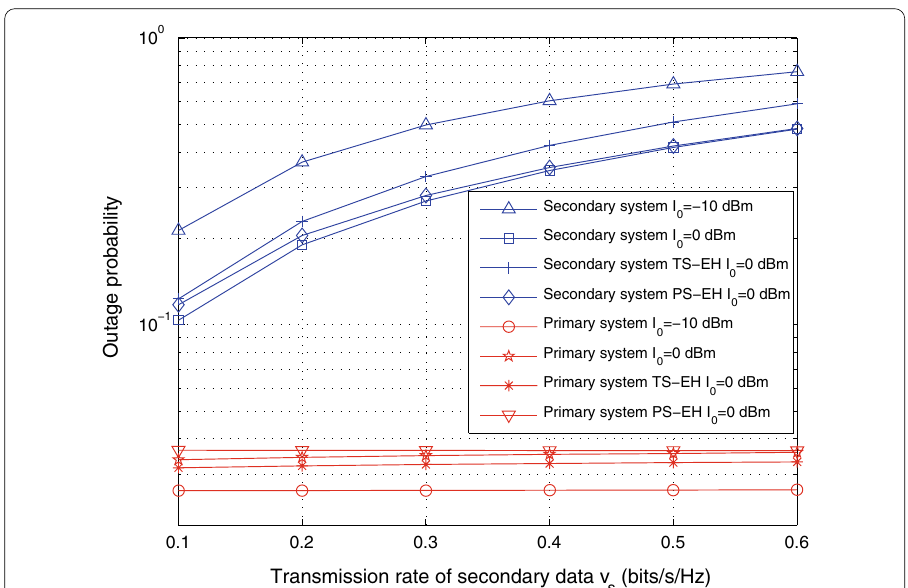
Fig. 5 Outage probability versus the secondary data rate v